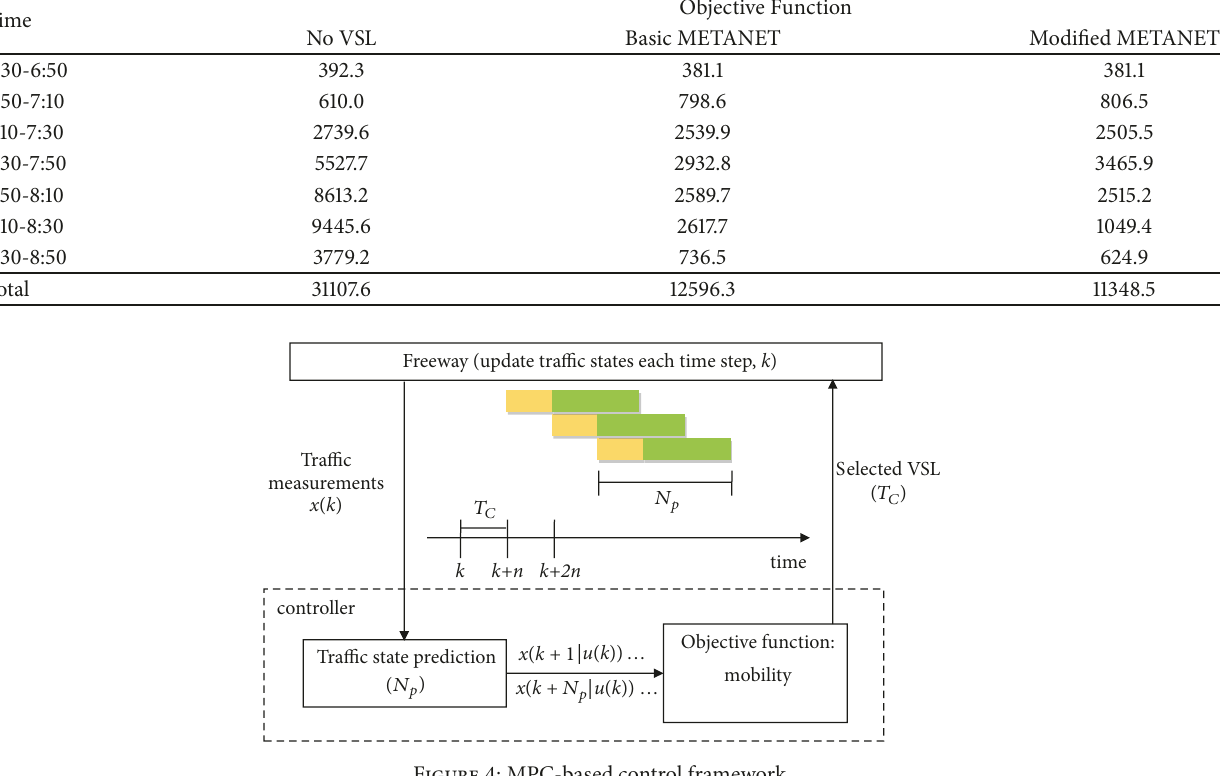
Figure 4: MPC-based control framework.